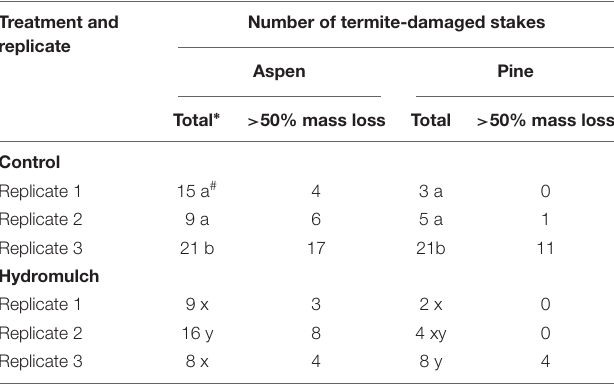
TABLE 5 | Effect of treatment replicate on the incidence of subterranean termite attack and resulting mass loss of mineral soil aspen and pine stakes after the Cedar Fire near Alpine,